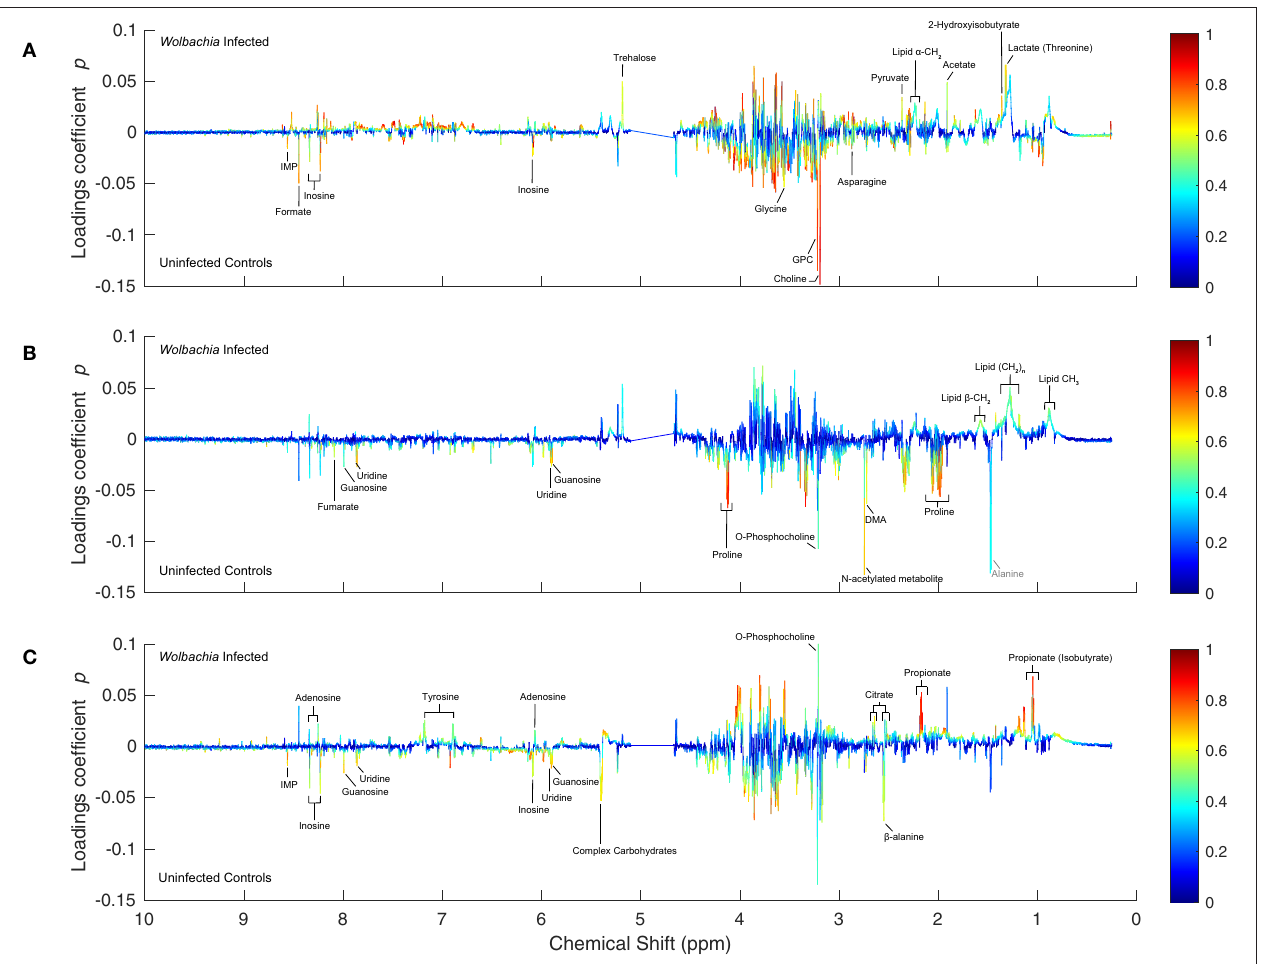
FIGURE 2 | One-dimensional S-plots of the pairwise OPLS models comparing Wolbachia -infected insects with the uninfected controls. (A–C) For all panels, the loadings coefficients p were plotted against the chemical shift of the respective variables in the NMR spectrum, and the correlation-scaled loadings coefficients | p ( corr )| were superimposed on the loadings plot as a heatmap color scale. The significantly altered metabolites ( | p | ≥ 0.015 & | p ( corr )| ≥ 0.45) are annotated in black in each panel: (A) High-iron diet (model M5 ), (B) Standard-iron diet (model M6 ), and (C) Low-iron diet (model M7 ). Gray annotations: metabolites referred to in the